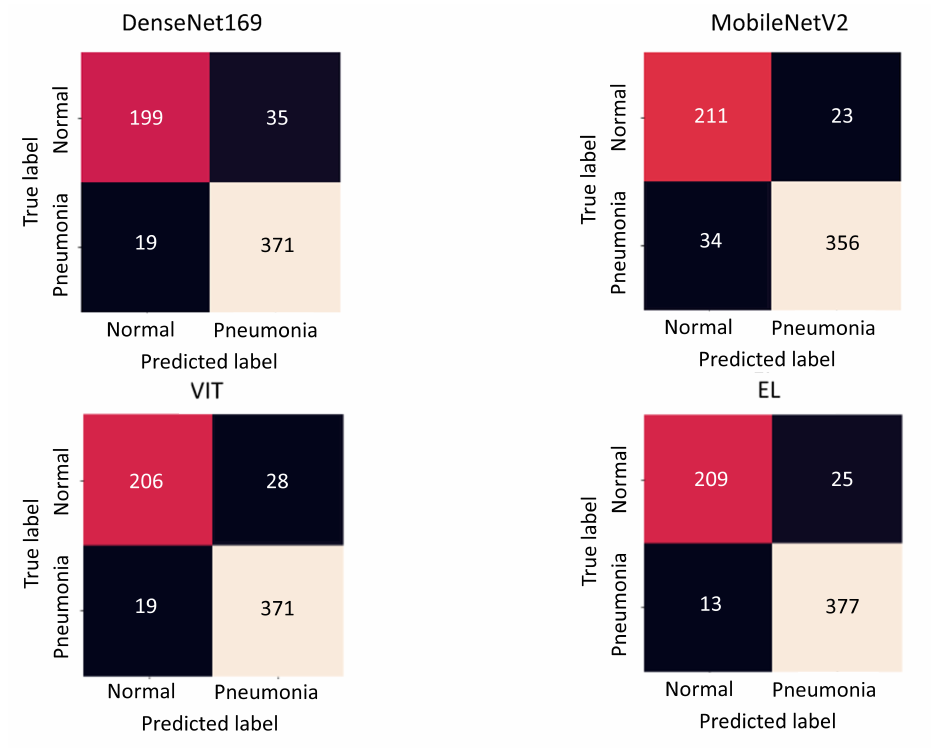
Figure 4. Confusion matrices of the chest X-ray data